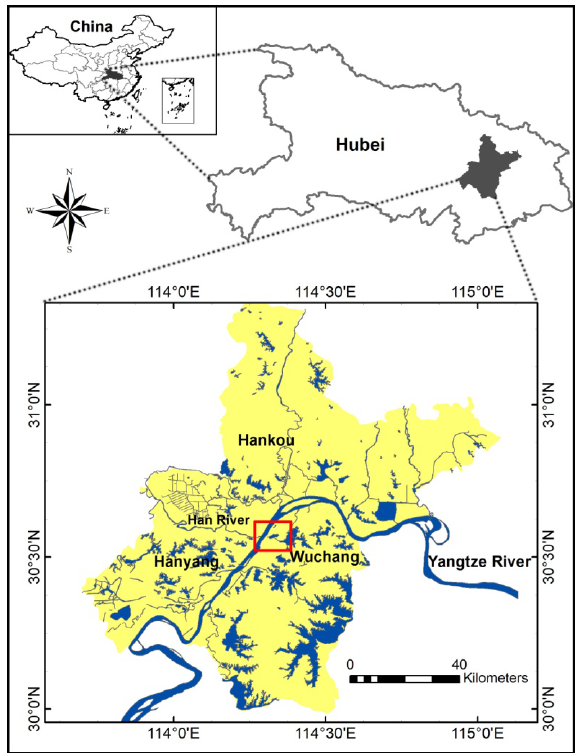
Figure 1. Location of the study area in Hubei, China.